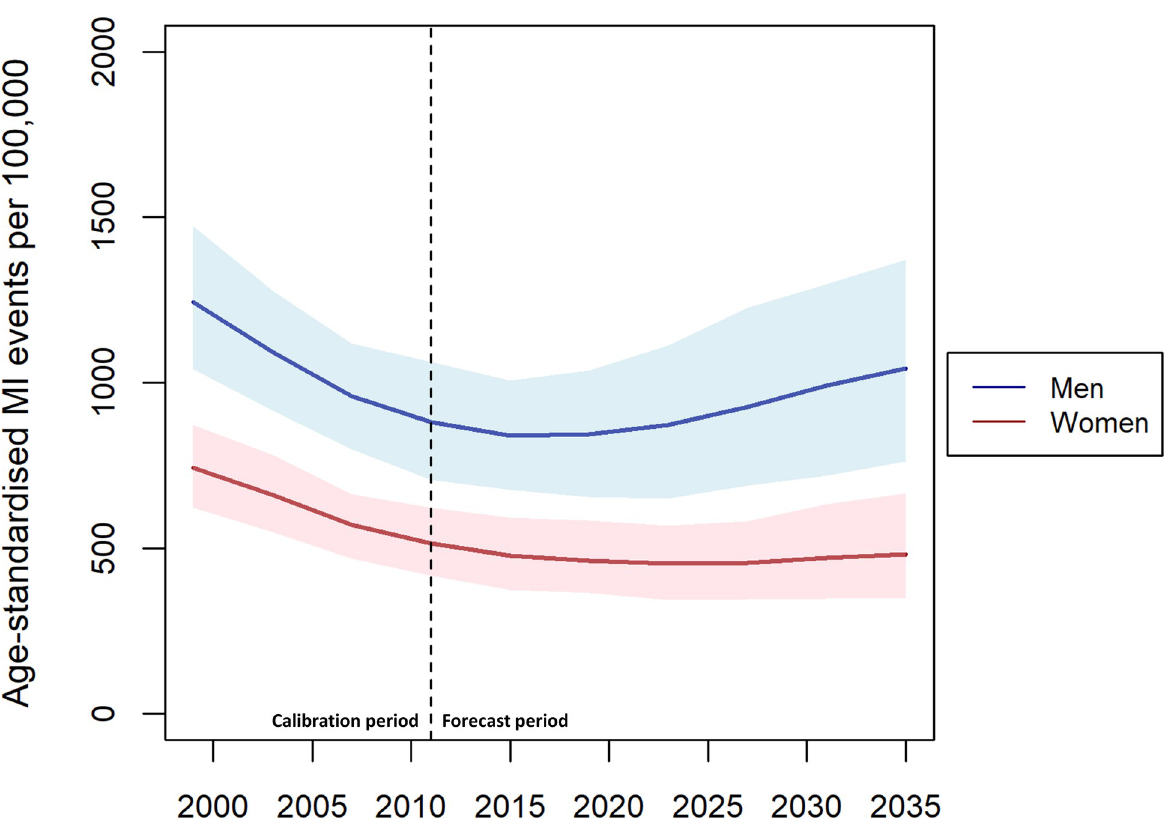
Fig 2. Modelled age-standardised event rates for MI (first and subsequent) for men and women, over 55s only, 1998–2035.